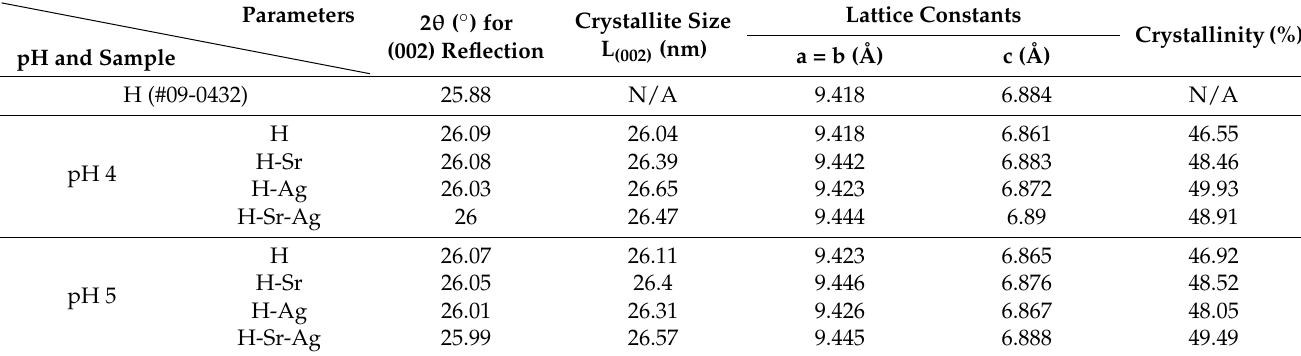
Table 3. Lattice parameters, crystallite dimension, and crystallinity calculated for the HAp-based coatings.